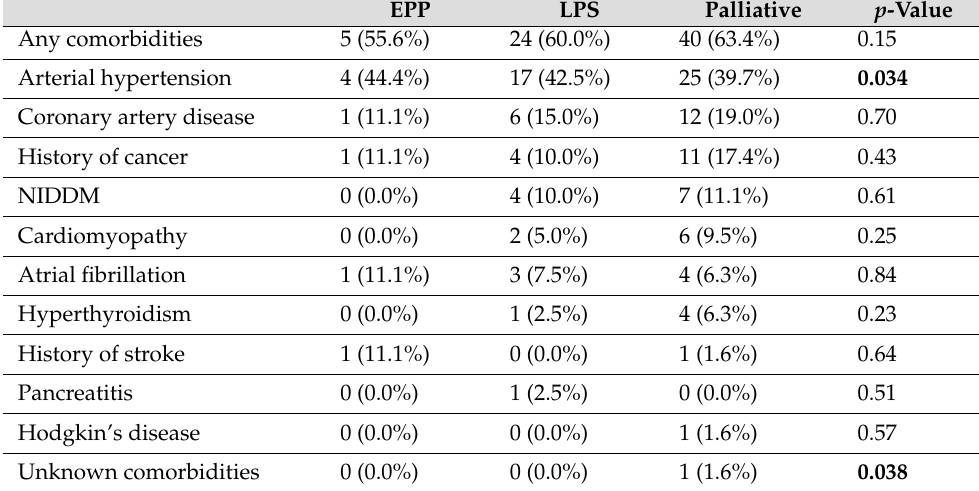
20.0%). There were no deaths reported in the first 30 days after the